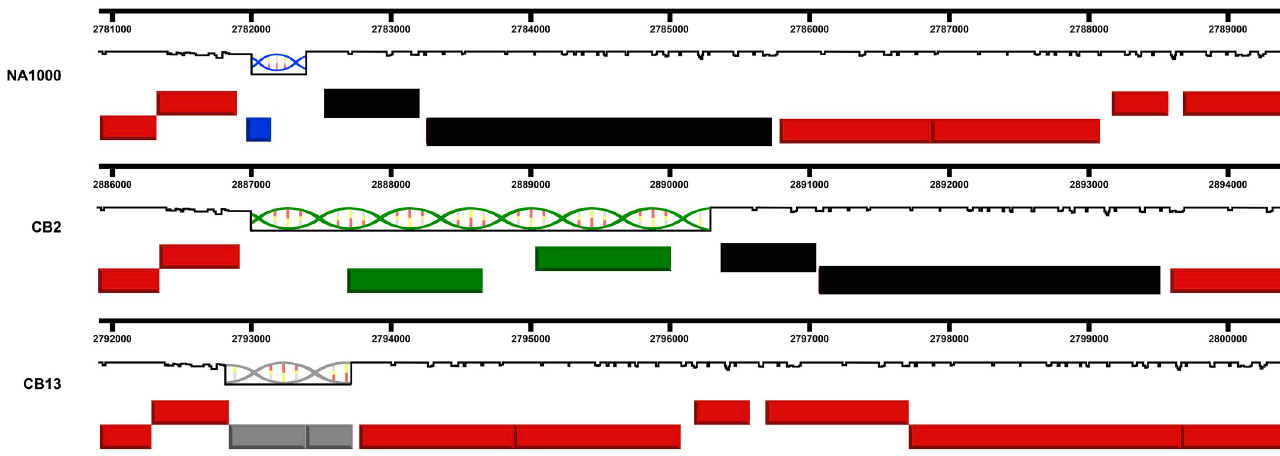
Fig 3. A comparison of the corresponding regions of the CB2, NA1000, and CB13 genomes. The red rectangles represent genes in shared regions of the three chromosomes. The helices represent three different insertions at the same location in each genome. The genes represented by the black rectangles are not present on the CB13 genome. The blue, green, and gray rectangles represent genes that are present in only one of the three genomes.